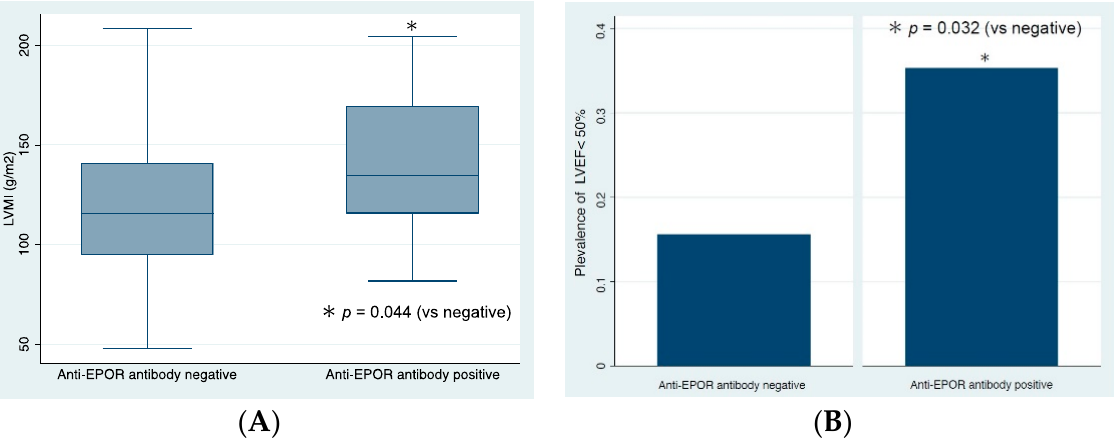
Figure 2. Cardiac function of patients with and without anti-EPOR antibodies. ( A ) Levels of left ventricular mass index (LVMI) and ( B ) prevalence of left ventricular ejection fraction (LVEF). EPOR, erythropoietin